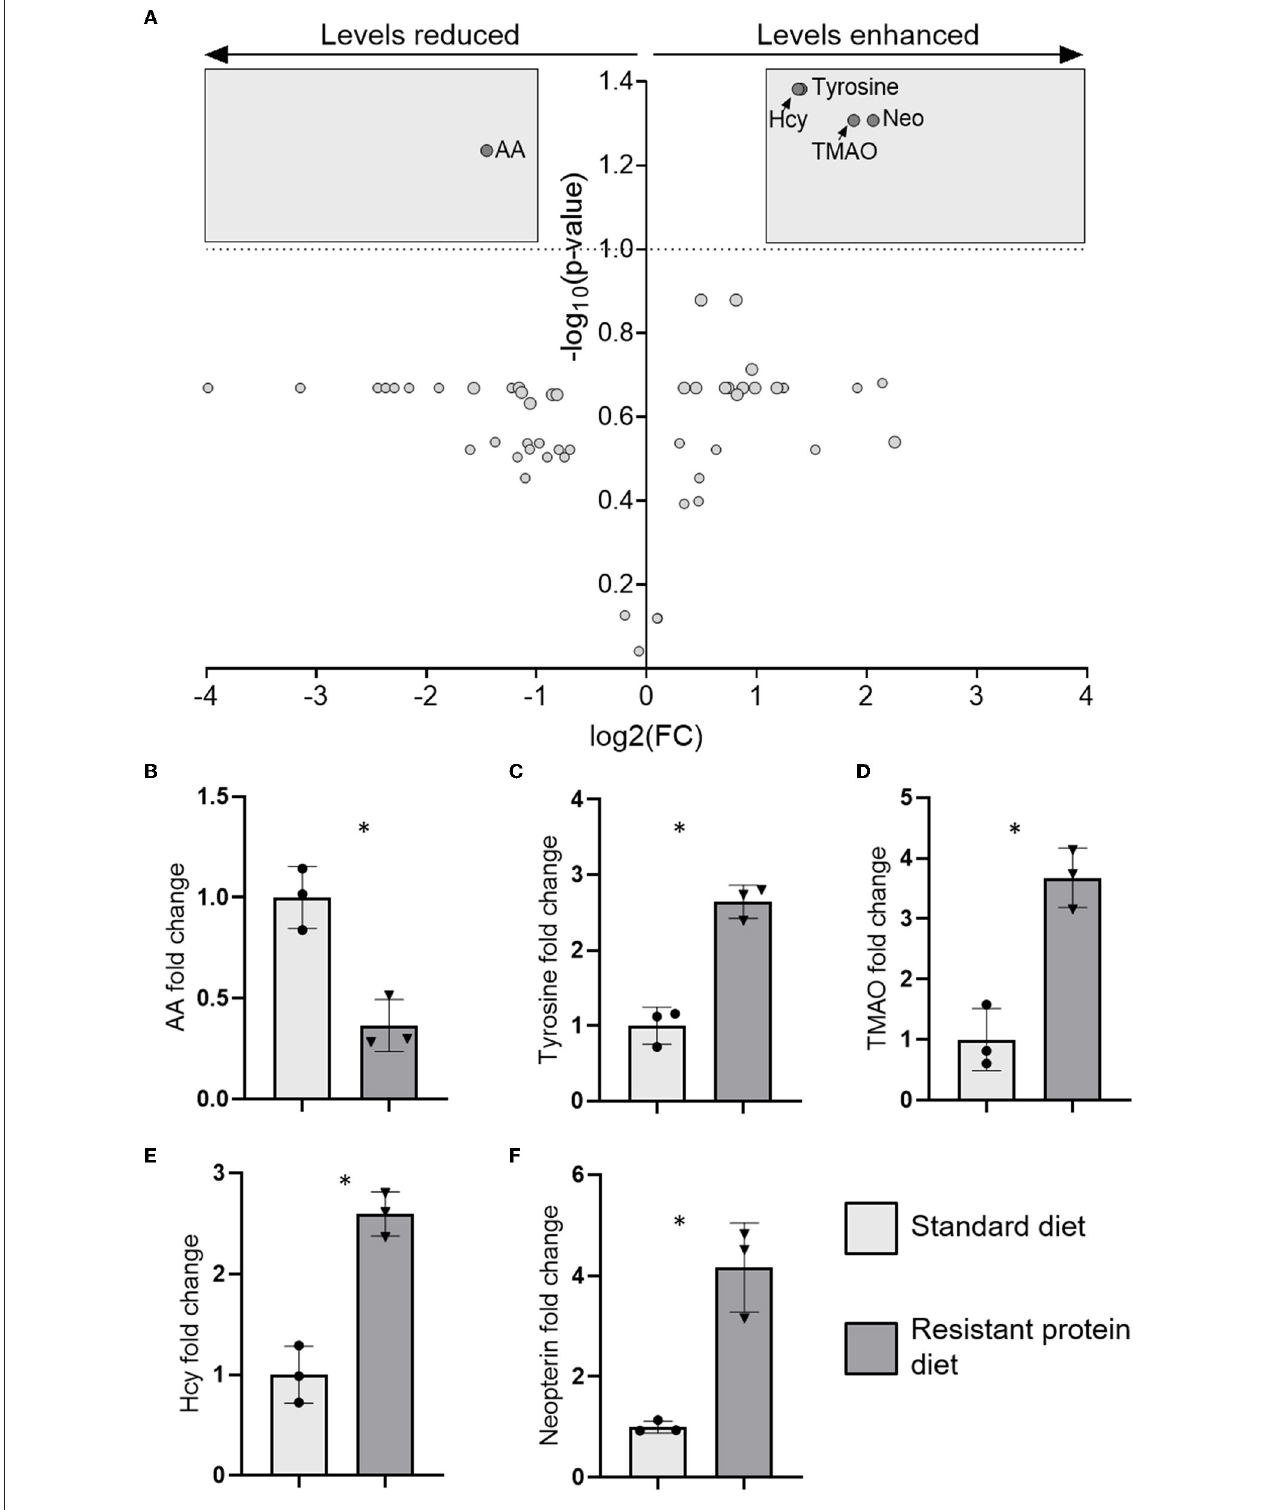
FIGURE 7 | The results of metabolomics analysis in plasma showing (A) volcano plot of five significantly differentiated metabolites after applying a fold-change threshold of 2 and false discovery rate (FDR) (q) of 0.1, and the fold change of those individual metabolites (B) acetic acid (AA), (C) tyrosine, (D) tri-methylamine-N-oxide (TMAO), (E) homocysteine (Hcy), and (F) neopterin (Neo). Data represent the mean and SD, with individual data points identified as circles (standard diet) and triangles (resistant protein diet). Statistical difference between groups is designated as follows: * p < 0.05.